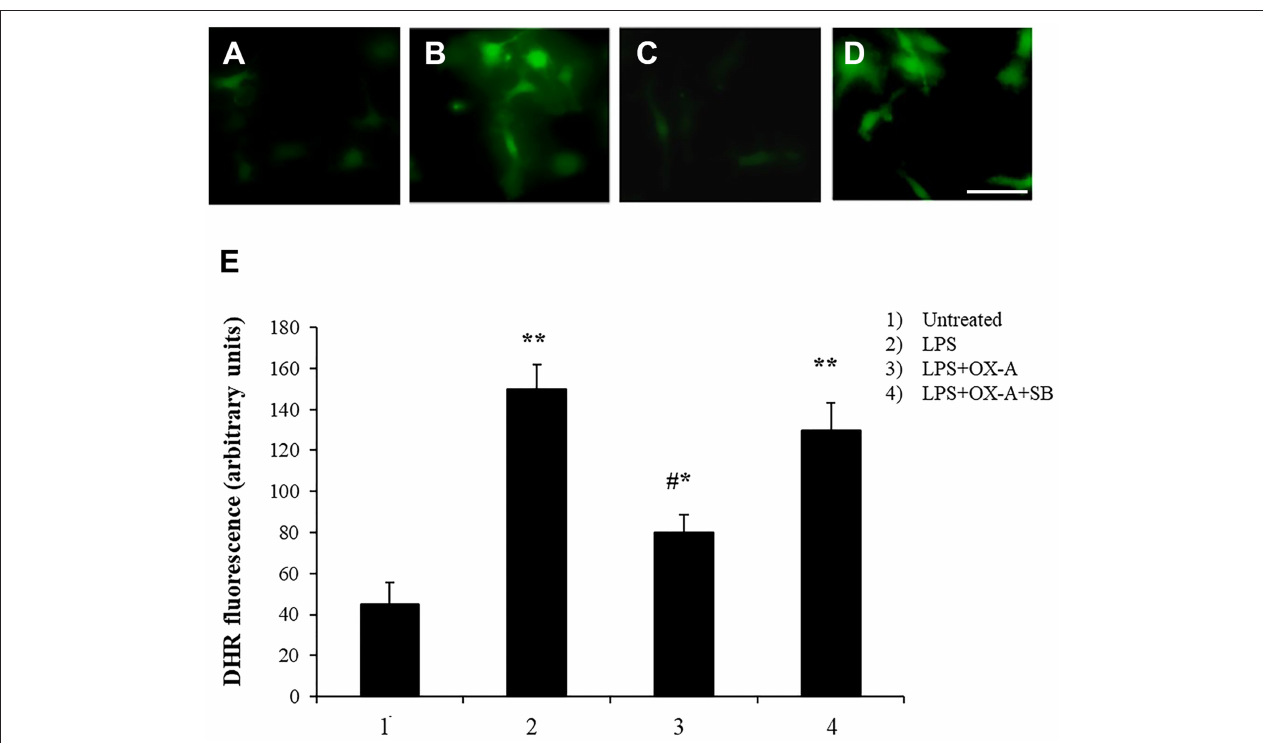
FIGURE 3 | Apical OX-A decreases LPS-induced ROS formation in basolateral primary cultures of microglia. (A–D) Representative micrographs of ROS accumulation in primary cultures of microglia co-cultured with Caco-2 as reported in Materials and methods. The transwell insert containing Caco-2 cells was added to the wells containing DHR-loaded microglia and treated in the apical compartment for 6h with LPS (0.5 µ g/ml) (B) or with LPS (6h; 0.5 µ g/ml) after a 30min pre-incubation with OX-A (0.2 µ M) in the absence (C) or presence of SB334867 (15min before OX-A; 10 µ M) (D) . A representative micrograph of control cells is also shown (A) . Scale bar: 20 µ m. After the treatments, microglia were observed with a Leica DMI6000 fluorescence microscope equipped with a Leica DFC320 cooled digital CCD camera (Leica Microsystems). The resulting images were analyzed to quantify the mean fluorescence of individual cells using Metamorph Imaging Software (Leica MetaMorph AF). (E) Graph bars showing DHR fluorescence in primary cultures of microglia co-cultured with Caco-2. Results represent means ± SEM of three separate experiments, each performed in duplicate. * P < 0.05, ** P < 0.001 compared to untreated cells; # P < 0.001 compared to LPS-treated cells (one-way ANOVA followed by Bonferroni’s